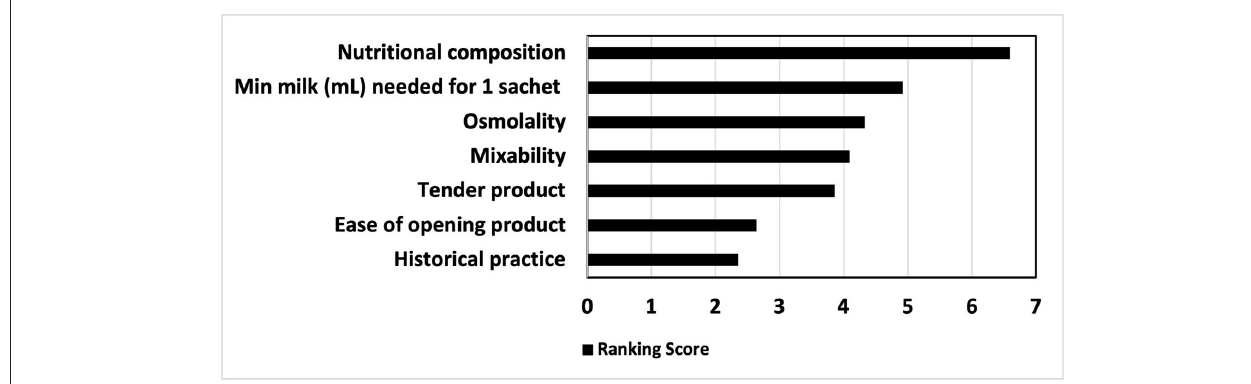
FIGURE 2 | Reasons guiding human milk fortifier choice, ranked in order of importance.